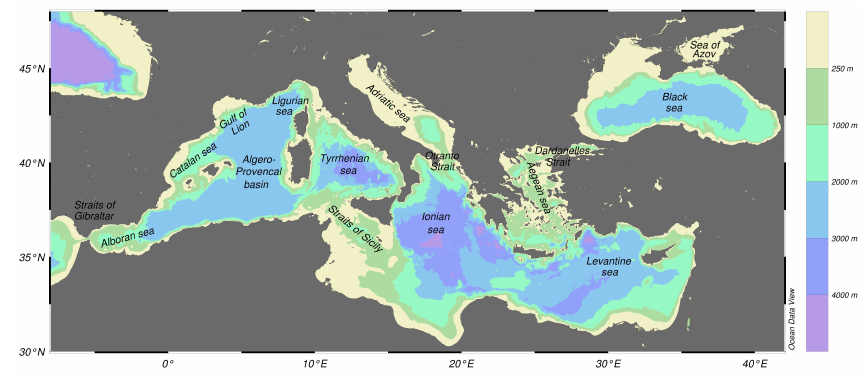
Fig. 1. Major seas, connecting straits and bottom topography of Mediterranean Sea.